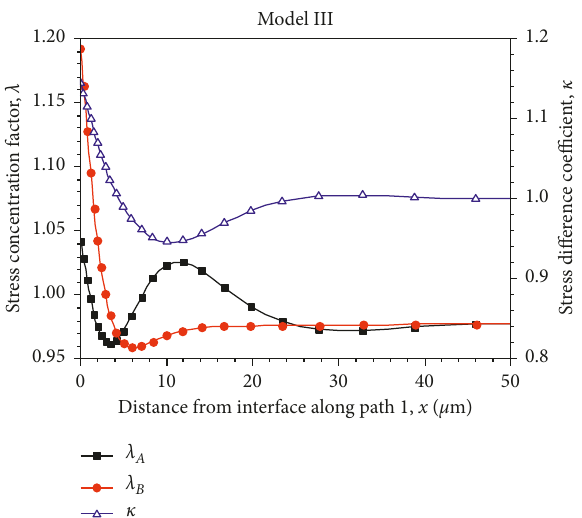
Figure 11: Mises stress concentration factor and Mises stress difference coefficient of model III along path 2.